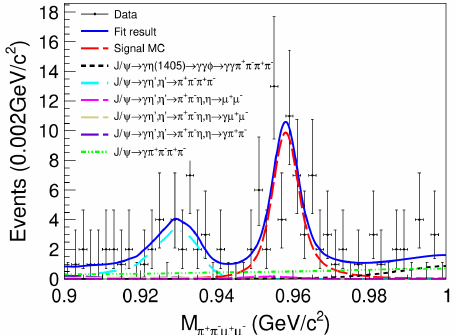
Figure 1: The π + π − µ + µ − invariant mass spectrum around the η (cid:48) mass. The dots with error bars represent the data, the red line is signal MC, and the blue line is the total fit result. The other dotted lines represent different backgrounds. The plot is reproduced from Ref [ 7 ] under the Creative Commons Attribution 4.0